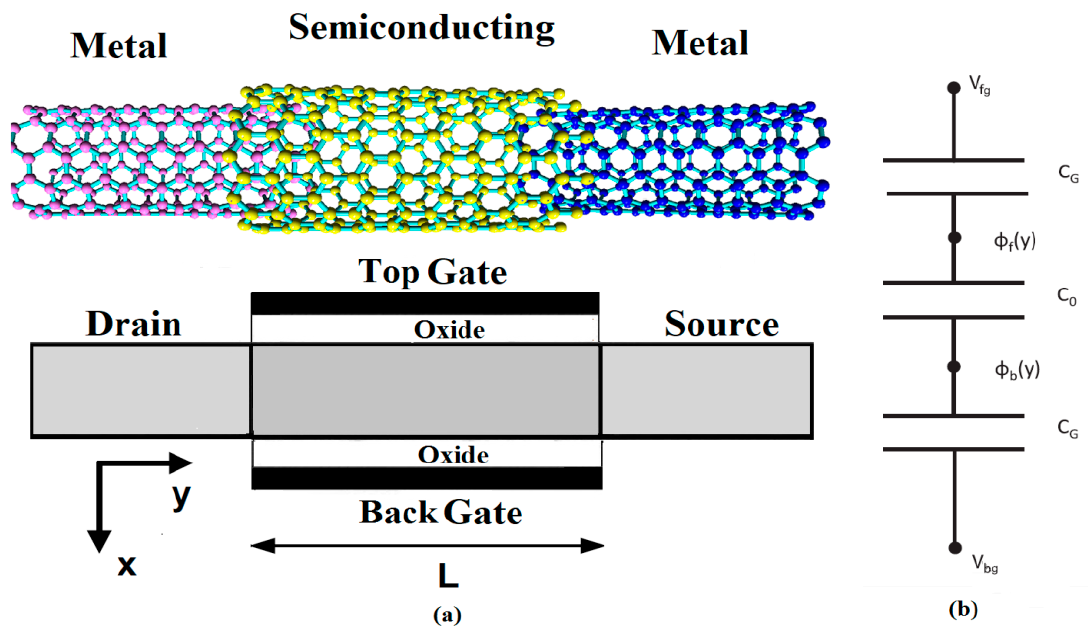
Figure 2. ( a ) The scheme of MSM contacts in the structure of the proposed GNS-based double gate FET, ( b ) equivalent circuit of device electrostatics.